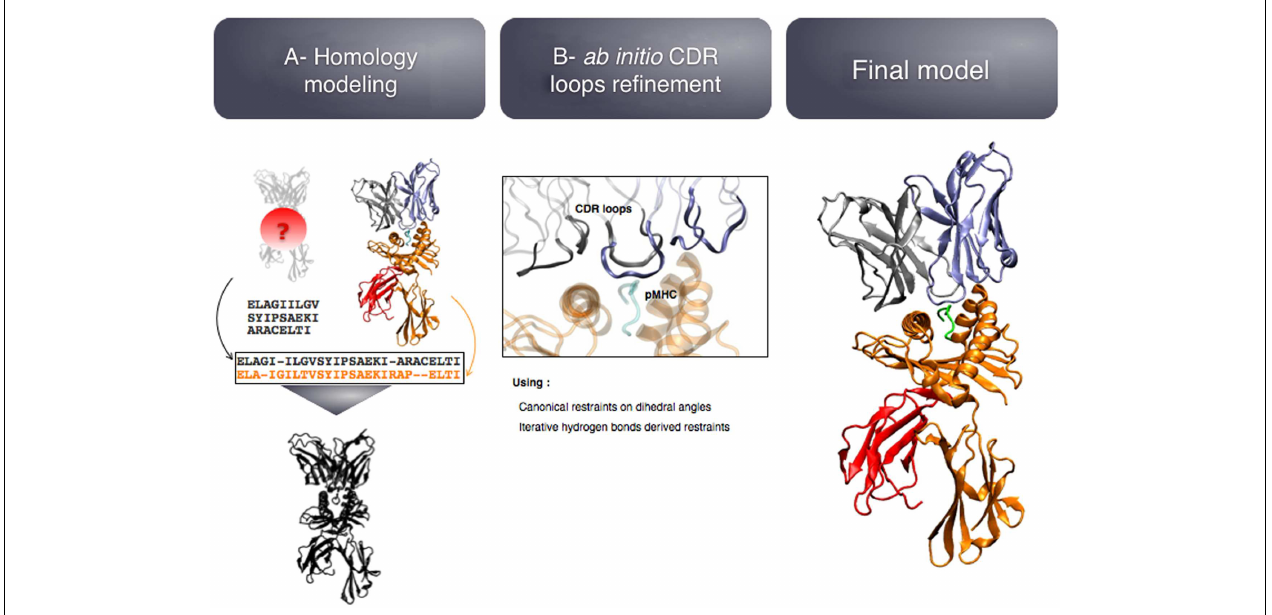
FIGURE 5 | Key steps of theTCRep 3D modeling procedure